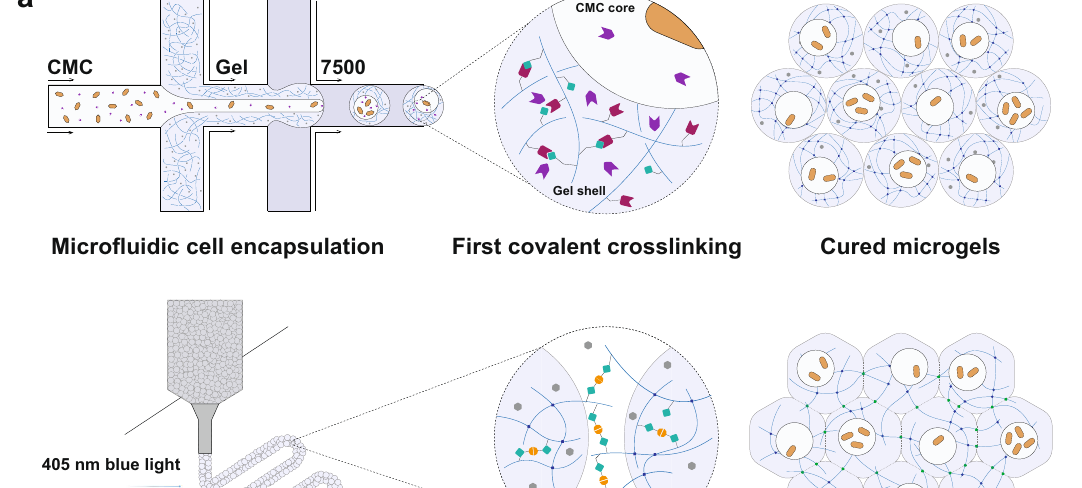
be controlled. Flow rates of the hydrogel precursor solution (shell phase) and the carrieroilarecontrolledat8and40 µ L/min,respectively,andthe fl owratesofCMC (core phase) are 1, 2, and 3 µ L/min, for small, medium, and large core size, respectively, n =50microgelsanalyzed inoneexperiment. c PrintedPAMscaffolds and the micrograph shows local magni fi cation of two intersected fi laments. Data arepresentedasmeanvalues±standarddeviationandsourcedataareprovidedas a Source Data fi